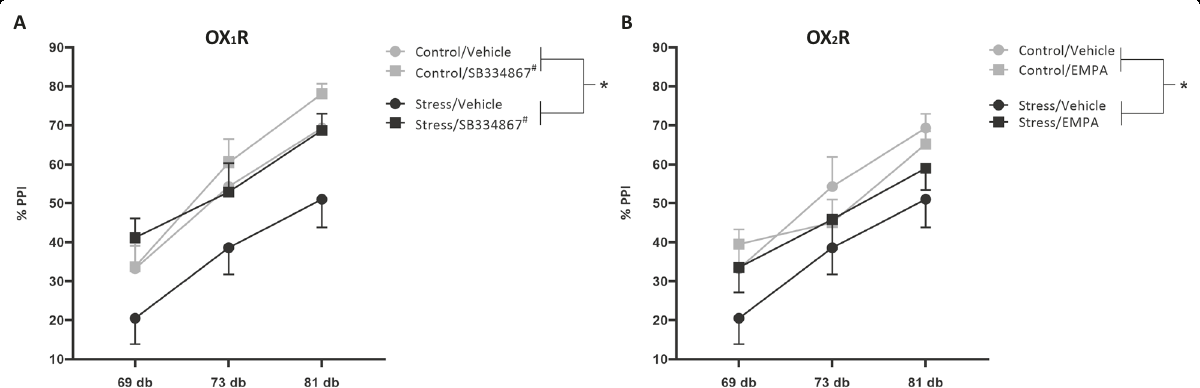
Fig. 4 OX 1 R antagonist, not OX 2 R antagonist, alleviates stress-induced de fi cits in PPI. As previously observed, two-day inescapable foot-shock produces de fi cits in PPI. These de fi cits were attenuated following systemic administration of the OX 1 R antagonist, SB334867 ( a ) but not following systemic administration of the OX 2 R antagonist, EMPA ( b ). * p < 0.05 denotes stress animals were signi fi cantly different from control animals; # p < 0.05 compared with vehicle-treated